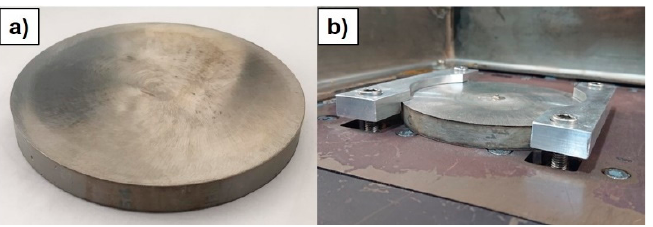
Figure 1. ( a ) circular Inconel 718 build platform used for LMD depositions; ( b ) Inconel 718 build platform clamped to the LMD workpiece table.